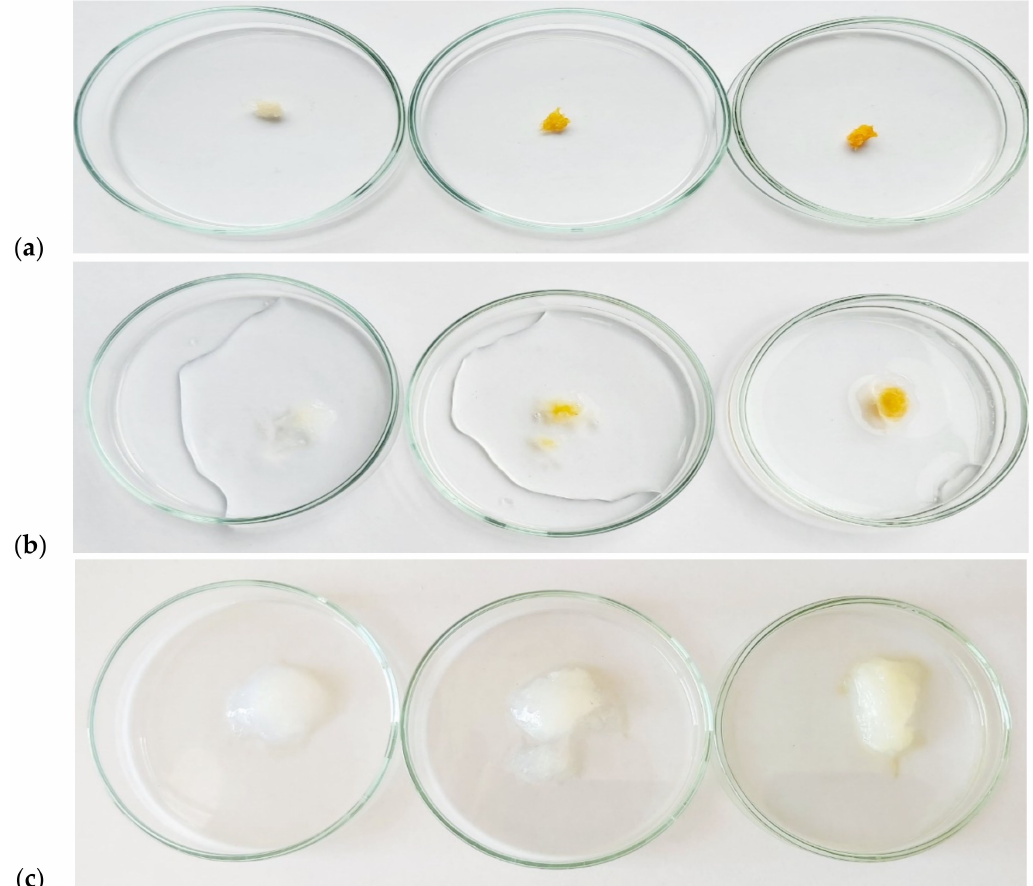
Figure 17. Synthesized hydrogels resulting from the polymerization of grafted carboxymethyl starch on chitosan with increasing amounts of vanillin ( a ) immediately after drying in a vacuum oven; ( b ) after adding a little deionized water; ( c ) structure and color of the hydrogel after liquid